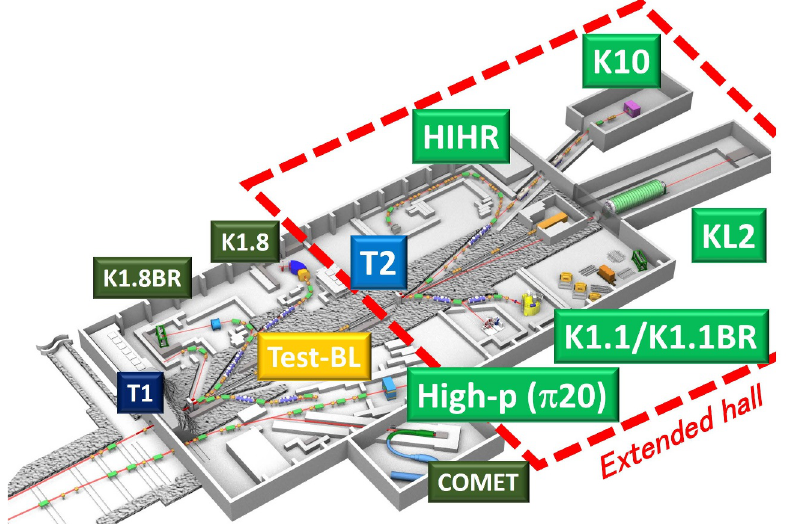
Figure 1. Layout of the extended Hadron Experimental Facility. The T2 production target and the HIHR, K1.1 / K1.1BR, KL2, and K10 beam lines will be newly constructed. In addition, the π 20 beam line and the test beam line are expected to be realized in the early stage of the